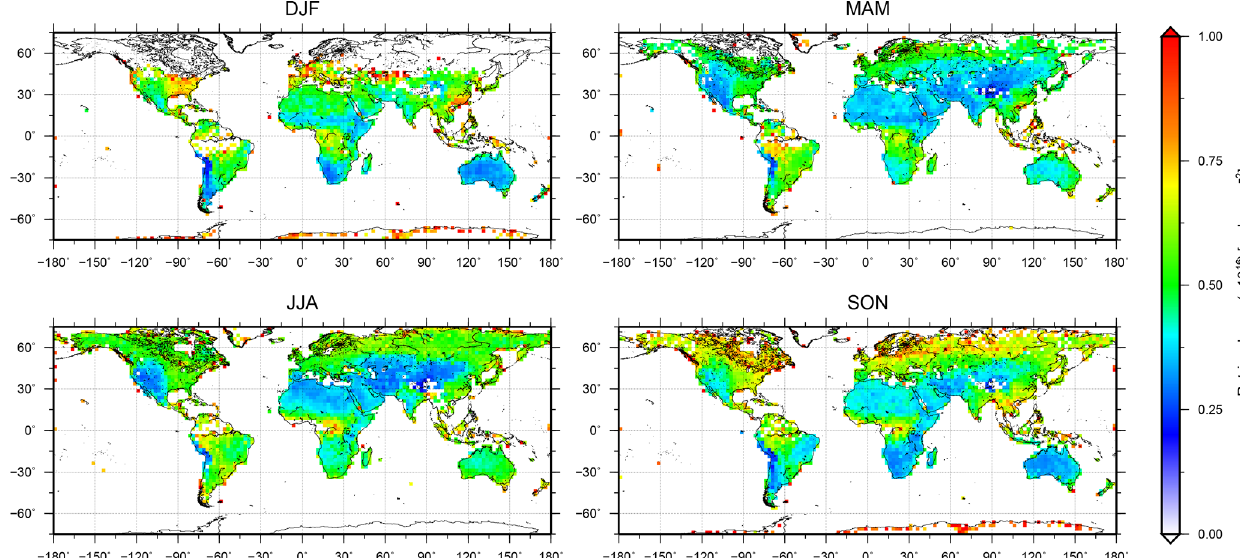
Figure 4. Same as Fig. 3 but for averaged